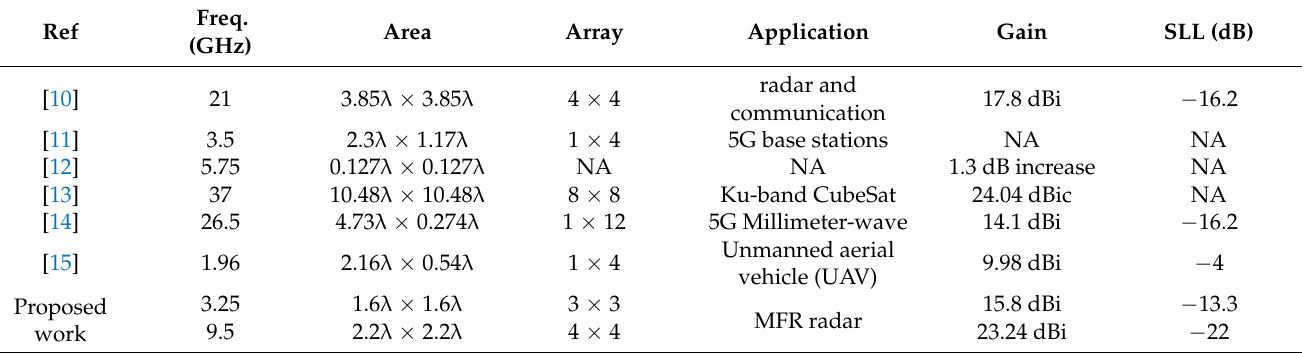
Table 2. Comparison of the proposed array antenna and reference